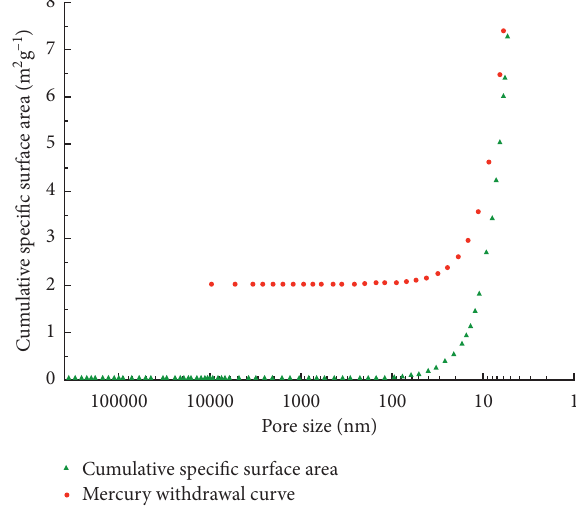
Figure 2: Accumulation of specific surface area with pore diameter.